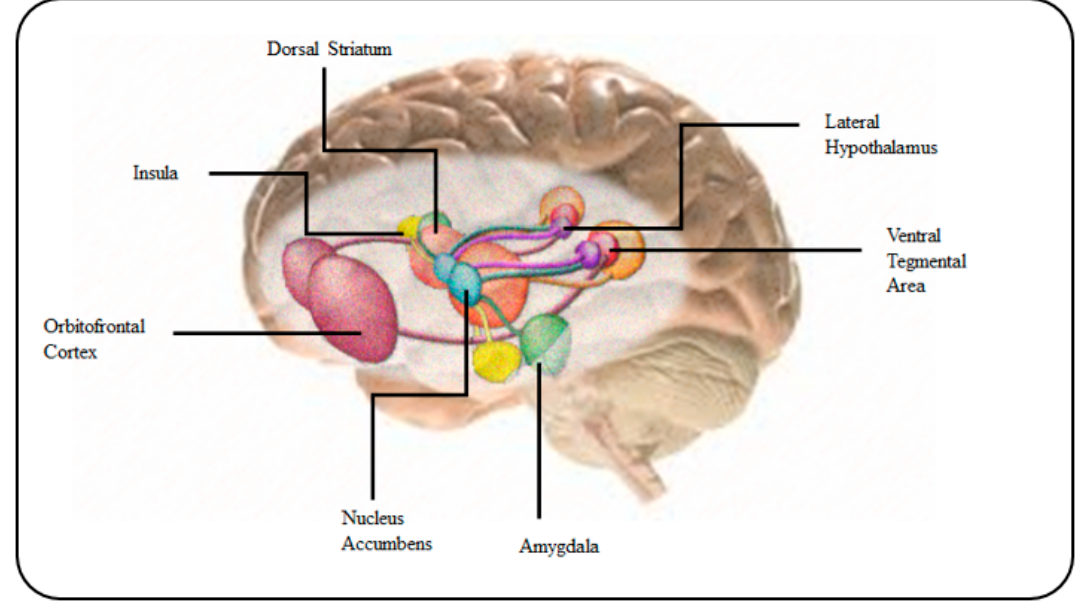
ff ect of food. Adapted from